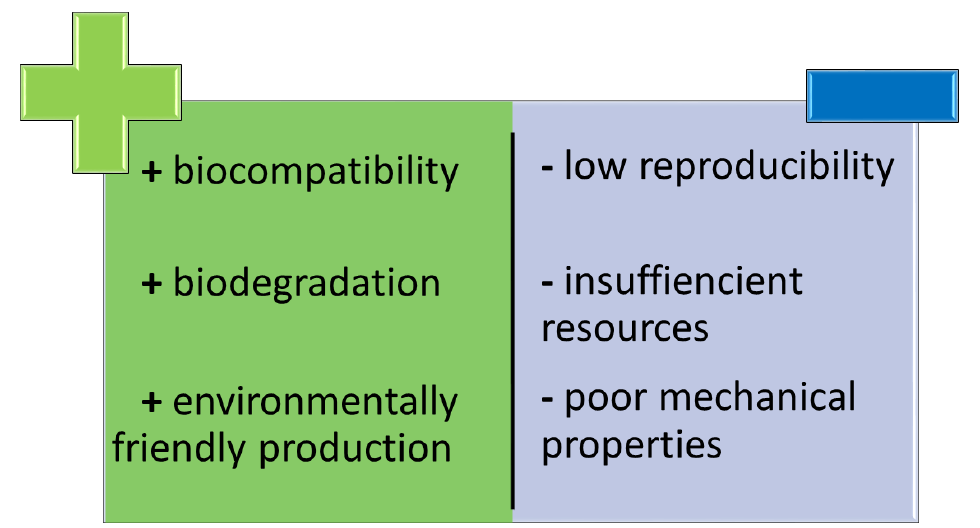
Figure 4. Comparison between advantages(+) and disadvantages( − ) of polymers originated from natural sources.